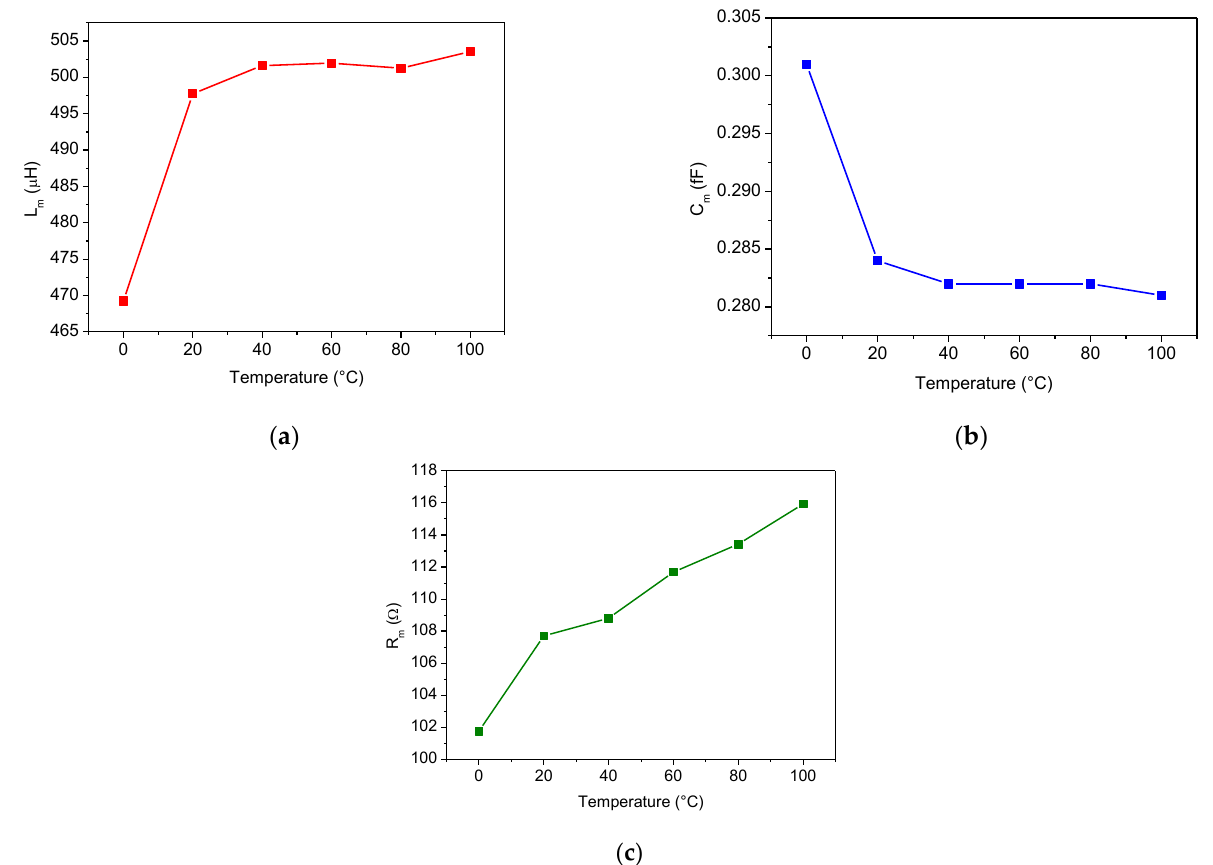
Figure 13. Temperature dependence of the motional elements: ( a ) L m , ( b ) C m , and ( c ) R m .